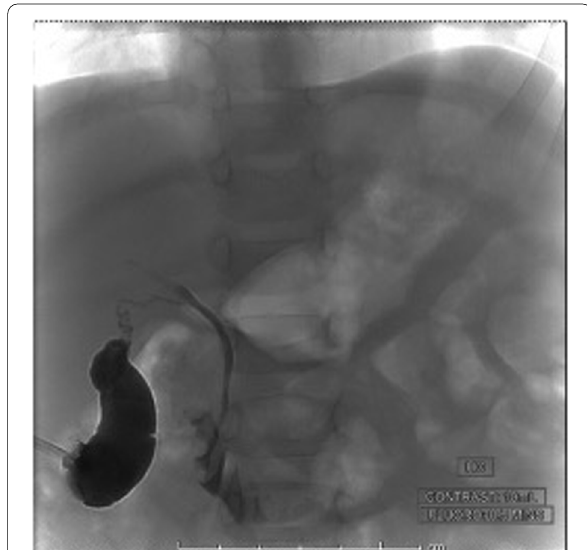
Fig. 3 Eight weeks post-op cholangiogram through cholecystostomy demonstrating patent cystic duct entering common bile duct with appropriate, uninterrupted drainage to duodenum